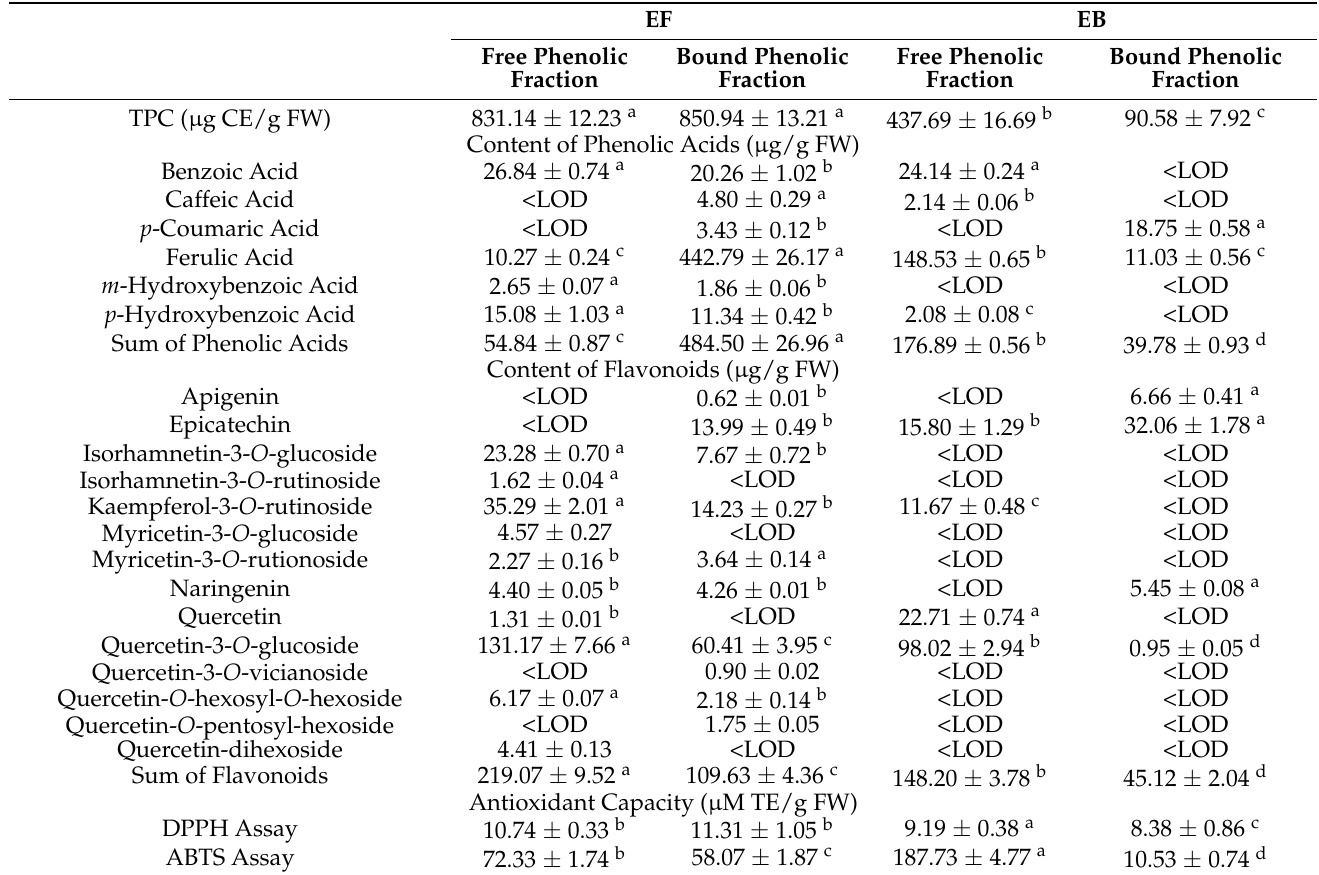
Table 1. Content of free and bound phenolic compounds and their antioxidant capacity ( x ± SD ) for elderflower dry extract (EF) and elderberry juice concentrate